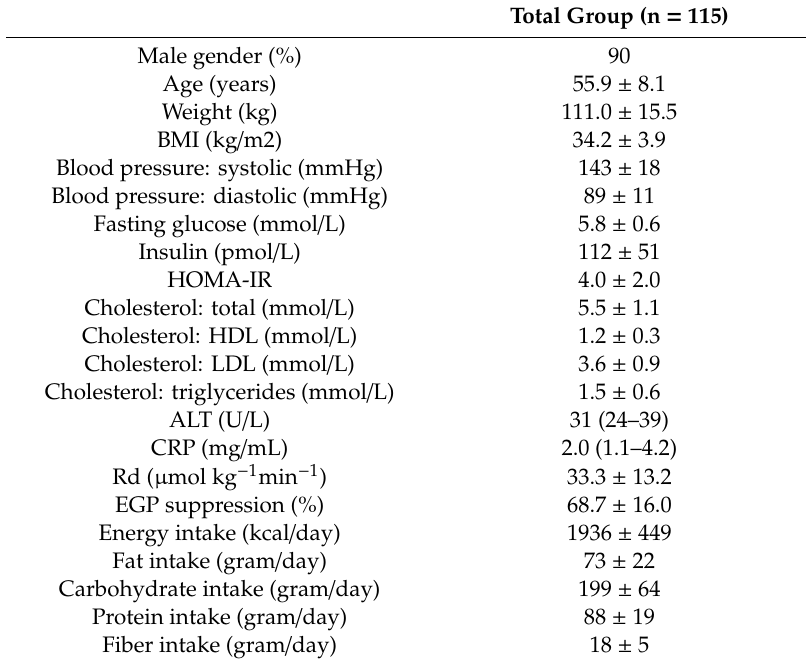
Table 1. Baseline characteristics, expressed as mean ± SEM or median